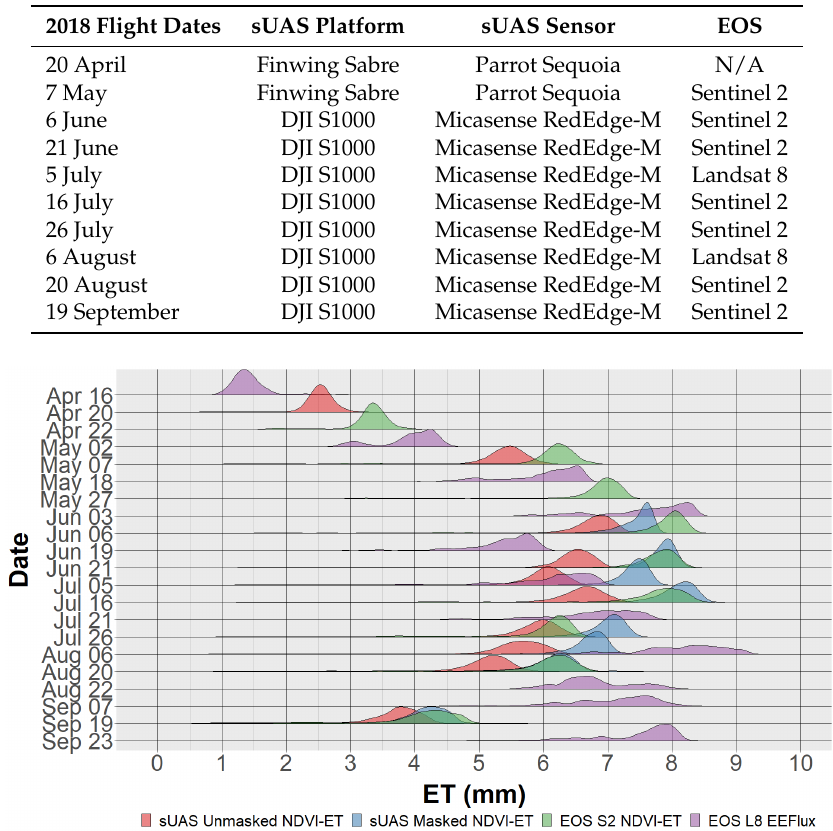
Figure 4. Daily Evapotranspiration (ET) in mm (x-axis) ridgeline density plot for each overpass date (y-axis) comparing each method used. Landsat 8 EEFlux is colored red, Sentinel 2 NDVI-ET is shown in orange, sUAS unmasked NDVI-ET is light blue, and sUAS masked NDVI-ET is